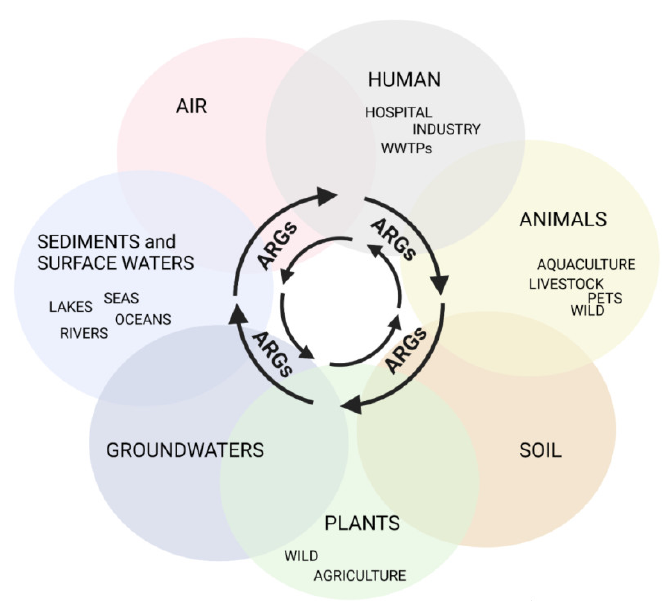
Figure 1. Routes of ARG transmission in the total environment, created with BioRender (available online: https://biorender.com accessed on 23 May 2022).